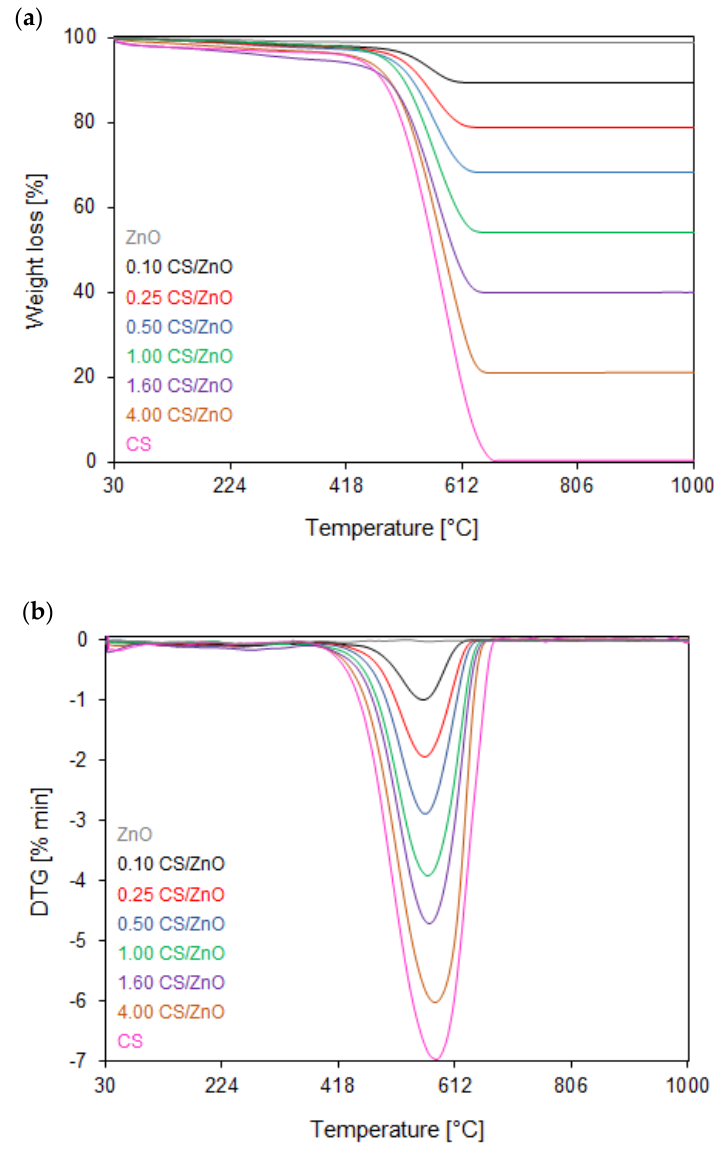
Figure 3. ( a ) TG and ( b ) DTG curves of reference ZnO, unmodified CS, and ZnO-modified nanocomposites with different carbon sphere contents measured in an oxidizing atmosphere.